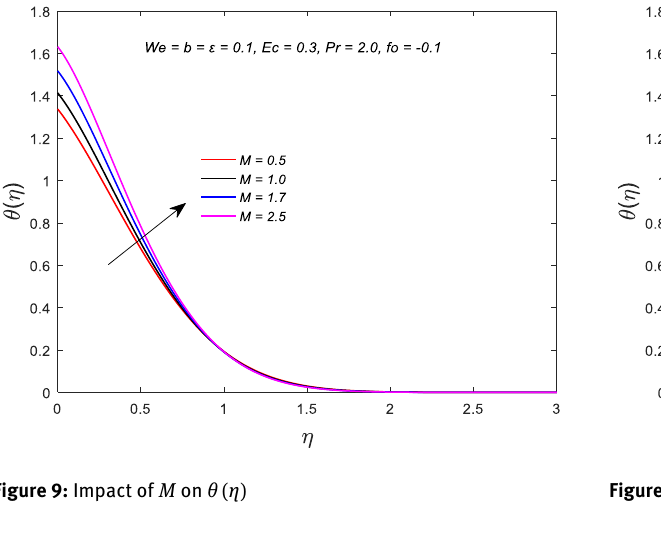
Figure 12: Effect of Ec on θ ( η )